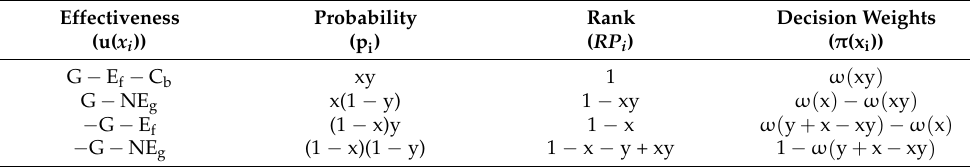
Table 3. Ranking of the expected benefits of the government.